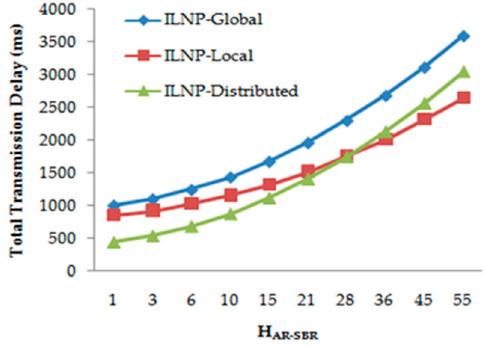
Figure 22. Impact of H AR-SBR on TTD.